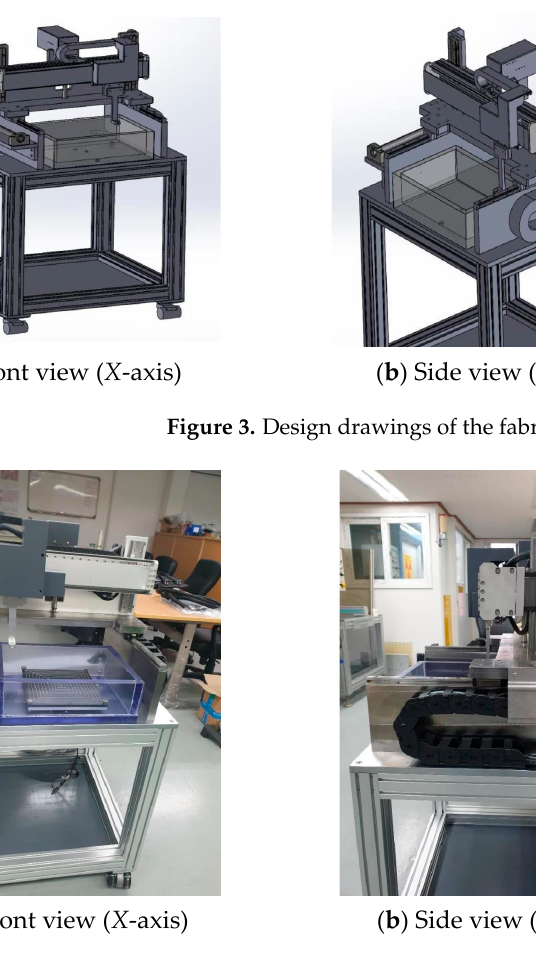
Figure 4. Fabricated 3-axis transport mechanism and frame. Table 2. Mechanical part performance.